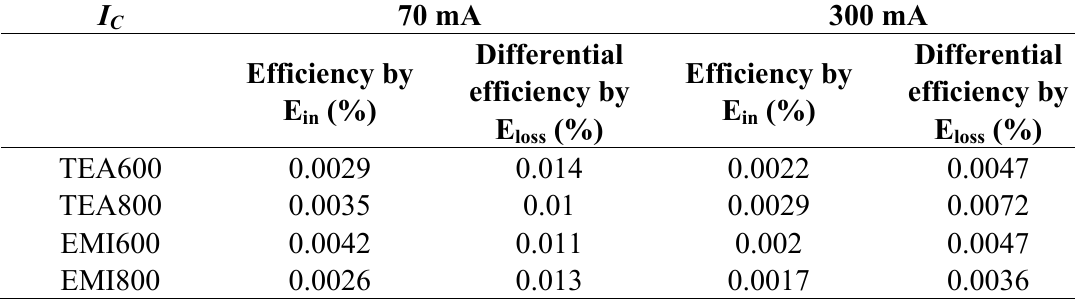
Table 5. Calculated efficiencies of the actuators at different charging current